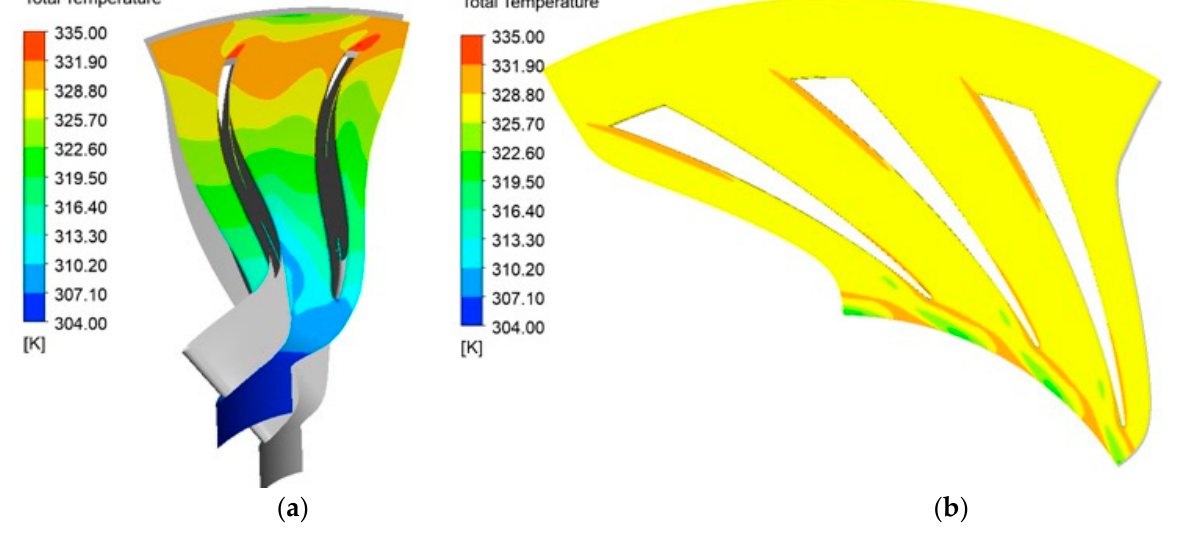
Figure 8. Total temperature: ( a ) lateral view at impeller mid-span; ( b ) blade-to-blade view at diffuser mid-span.